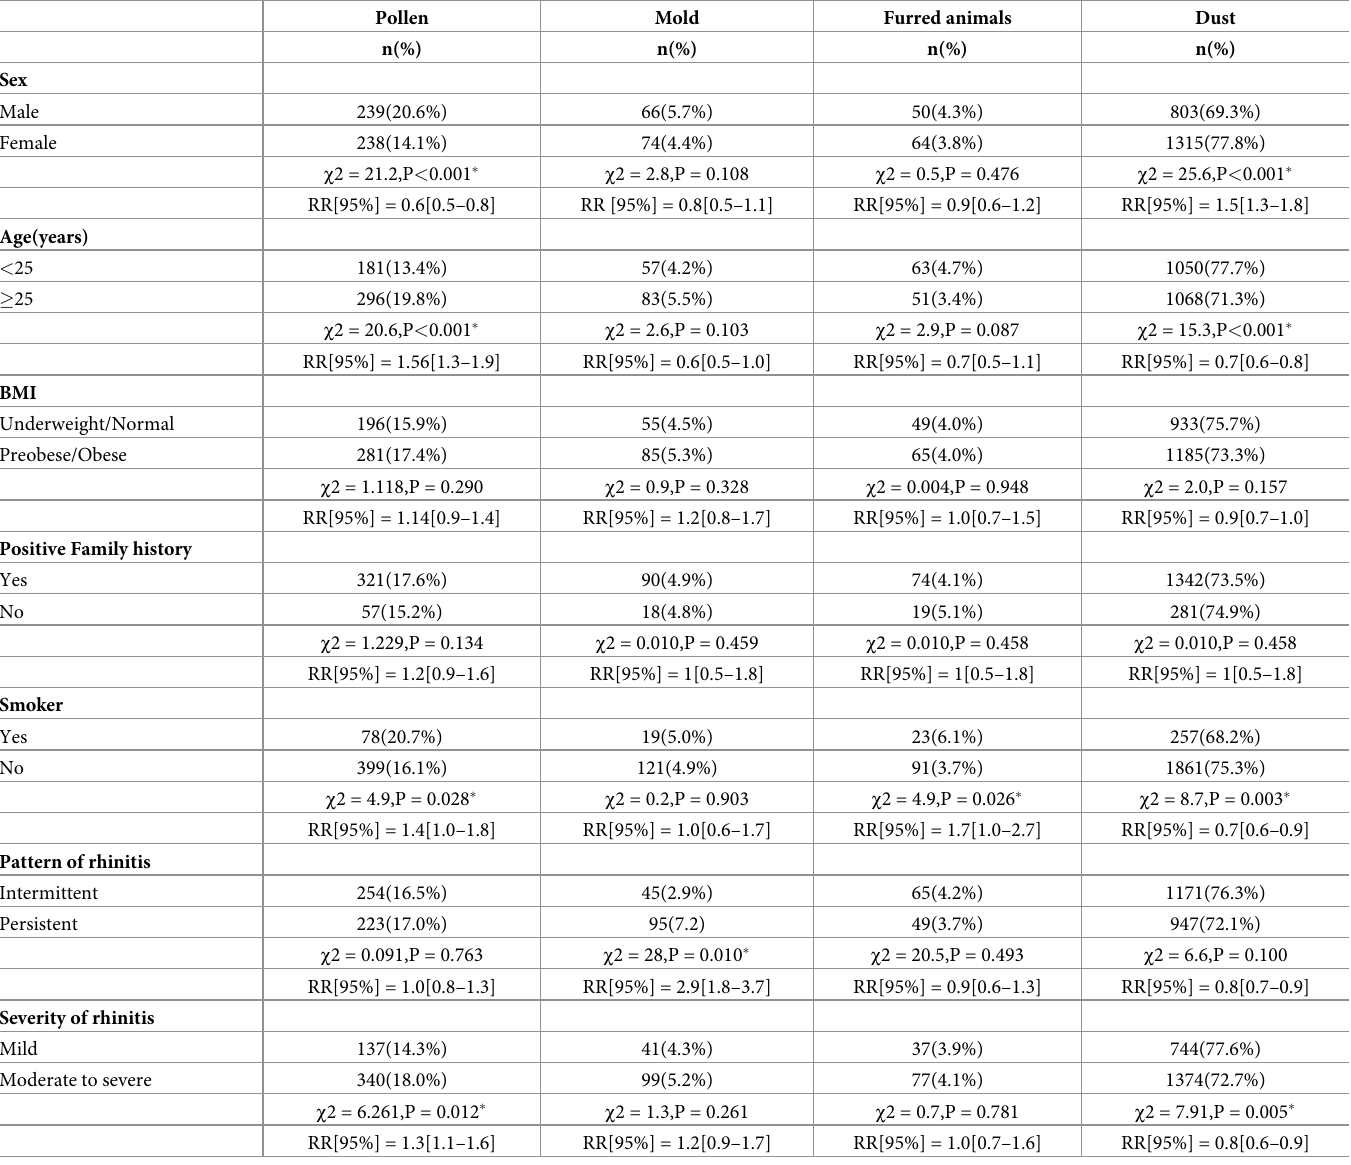
Table 3. Association between trigger of allergic rhinitis and sample